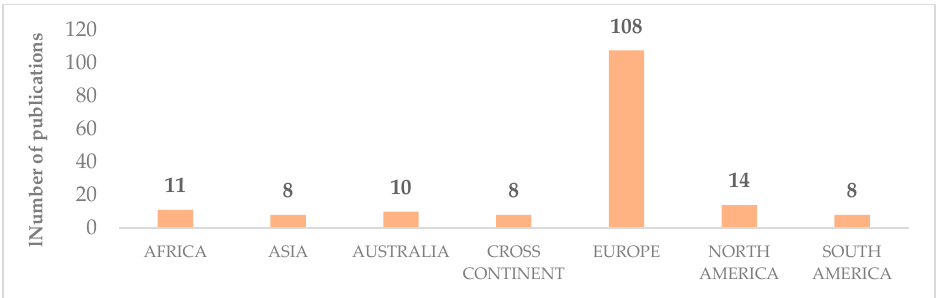
Figure 2. Geographical distribution of publications.